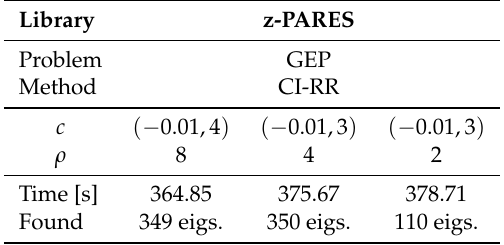
Table 13. ENTSO-E: impact of the search region of the CI-RR